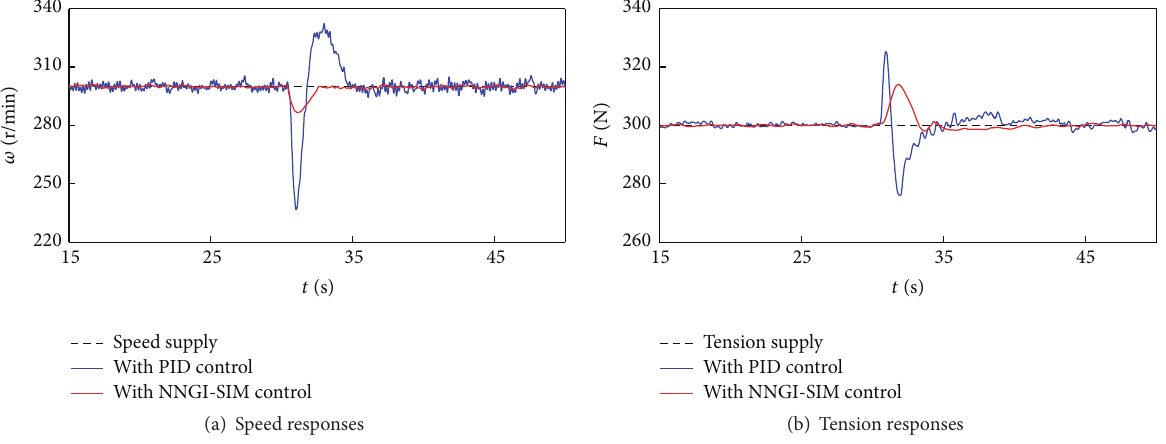
Figure 12: Experimental results for sudden increased load impact.